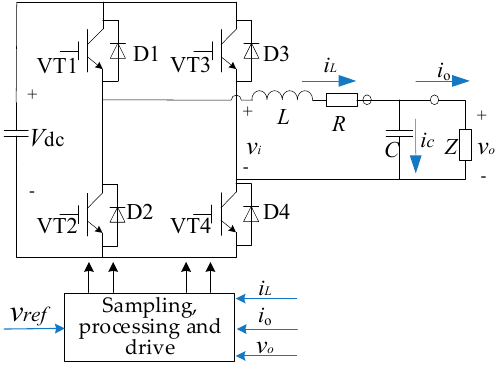
Figure 1. Pulse width modulation (PWM) inverter system.